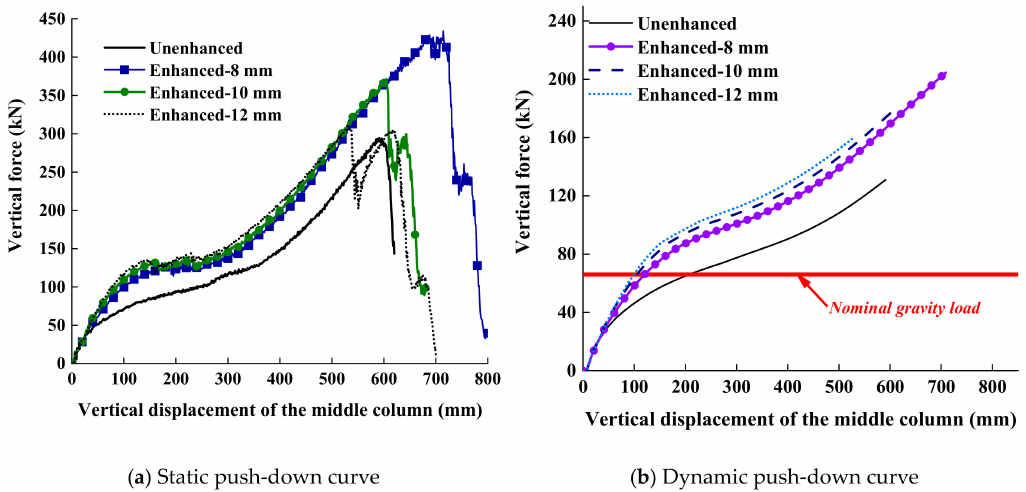
Figure 15. Comparison between the unenhanced and enhanced composite frame using retrofit strategy